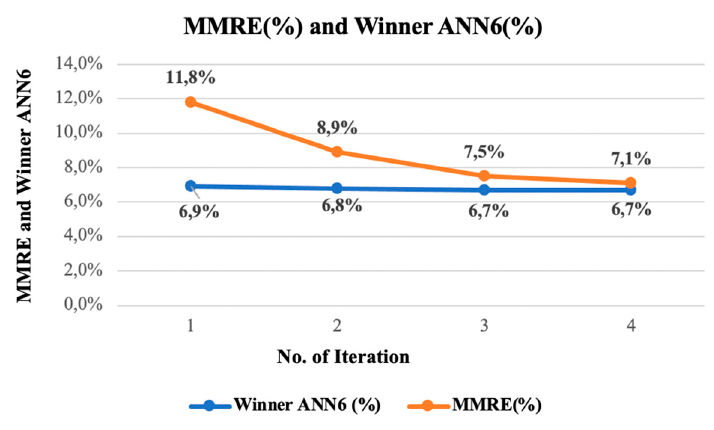
Figure 5. GA for ANN-L16-training part (UCP).